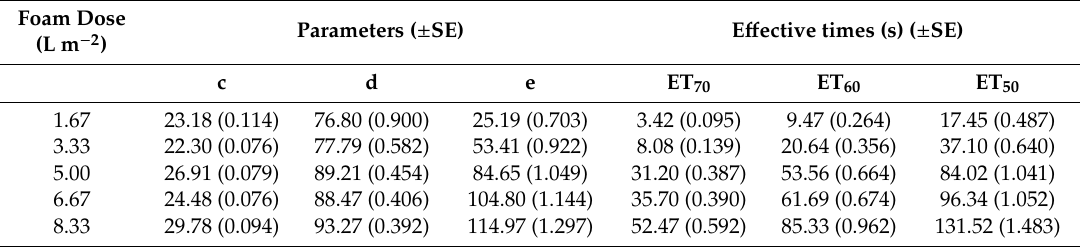
Table 1. Parameters of the exponential decay model (Equation (2)) and e ff ective times (s) estimated for reaching the temperatures of 70 ◦ C, 60 ◦ C, and 50 ◦ C (ET 70, ET 60, and ET 50, respectively) as a ff ected by the di ff erent foam doses and the passage of time. The non-linear regression curves are plotted in